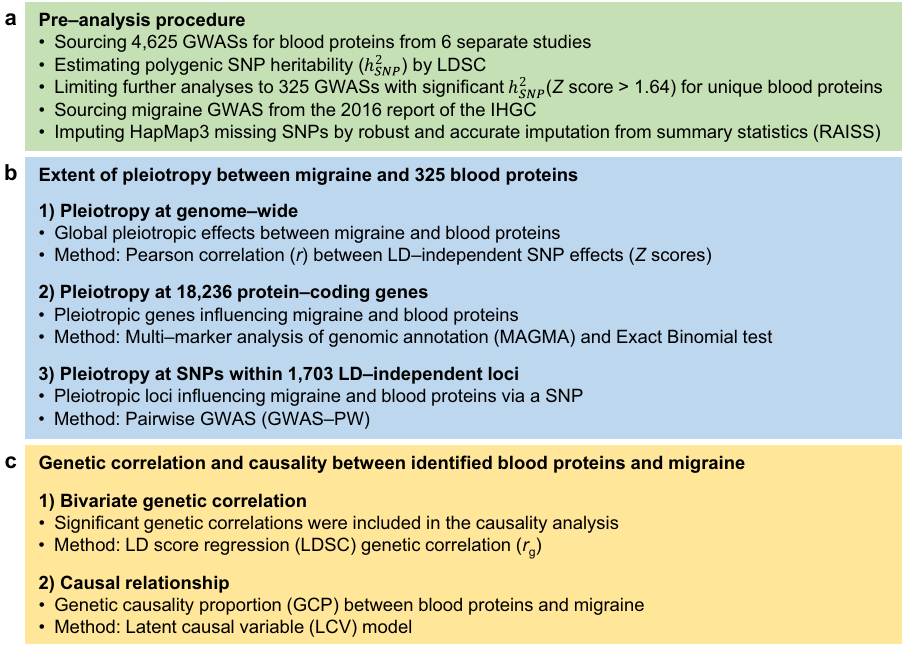
Fig. 1 Study work fl ow. a We fi rst collected 4625 publicly available GWAS summary statistics for blood proteins from six studies published between March 2016 and October 2020. Those studies with a sample size < 1000 were not resourced. The median sample size across all 4625 collected protein GWASs was 3301 individuals. We limited our analyses to GWASs with a nominally signi fi cant polygenic h 2 SNP ( P one-sided [ P h 2 ] < 0.05), resulting in 325 unique SNP proteins. This step was necessary as we aimed to investigate the shared “ polygenic ” genetic architecture between blood proteins and migraine. More importantly, this step minimises the multiple testing burden. For migraine, we used migraine GWAS summary statistics from the 2016 report of the International Headache Genetics Consortium (IHGC) comprising 59,674 migraine cases and 316,078 migraine-free controls. To have a consistent list of SNPs for all GWASs (325 protein GWASs and the migraine GWAS), we imputed HapMap3 SNPs using RAISS software. b We conducted comprehensive genetic analyses estimating pleiotropy between the included 325 proteins and migraine at three levels, [i] genome-wide (by estimating Pearson correlation between LD-independent SNP effects), [ii] 18,236 protein-coding genes (applying MAGMA and Binomial test), and [iii] SNPs within 1703 LD-independent loci (applying GWAS-PW). c The causal in fl uence of the identi fi ed proteins (from panel b ) was estimated by implementing a genome-wide approach (LCV model) when there is a nominally signi fi cant genetic correlation (estimated by LDSC) between the blood level of the protein and the risk of migraine. Table 1 Summary of the 325 unique blood protein GWASs (with a signi fi cant SNP heritability) analysed in this study. GWAS source